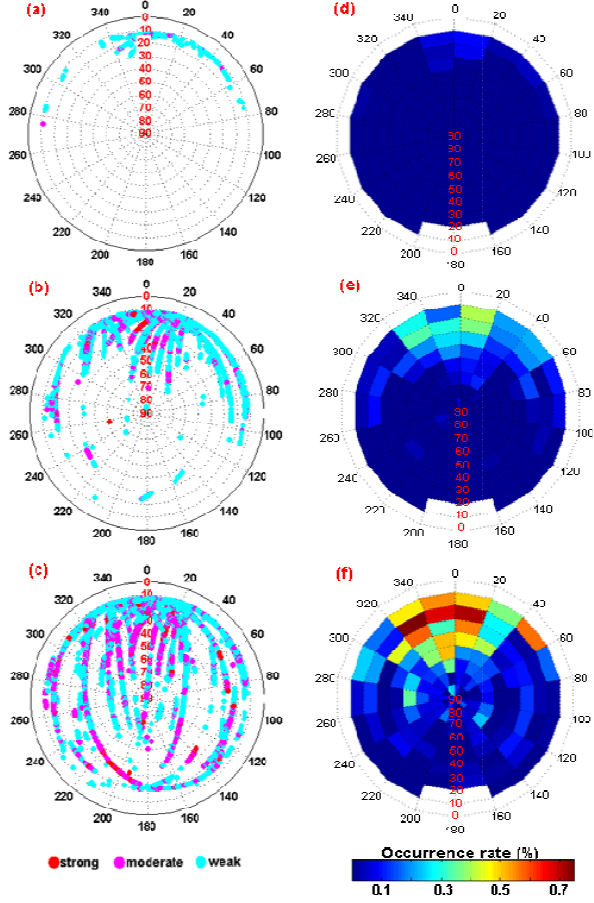
Fig. 6. The directional distribution of ionospheric scintillation for Bandung during (a) 2009, (b) 2010, and (c) 2011 and their occur- rence rate during (d) 2009, (e) 2010, and (f)